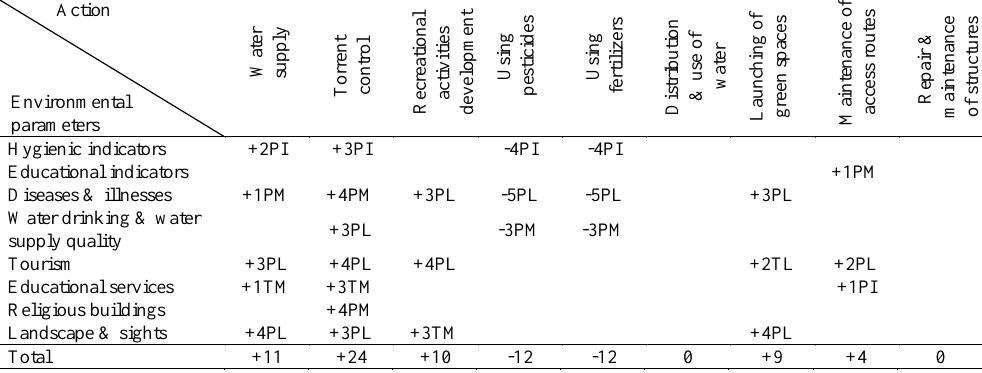
Table 9: Prediction matrix of cultural impact s of irrigation and drainage network in operation phase